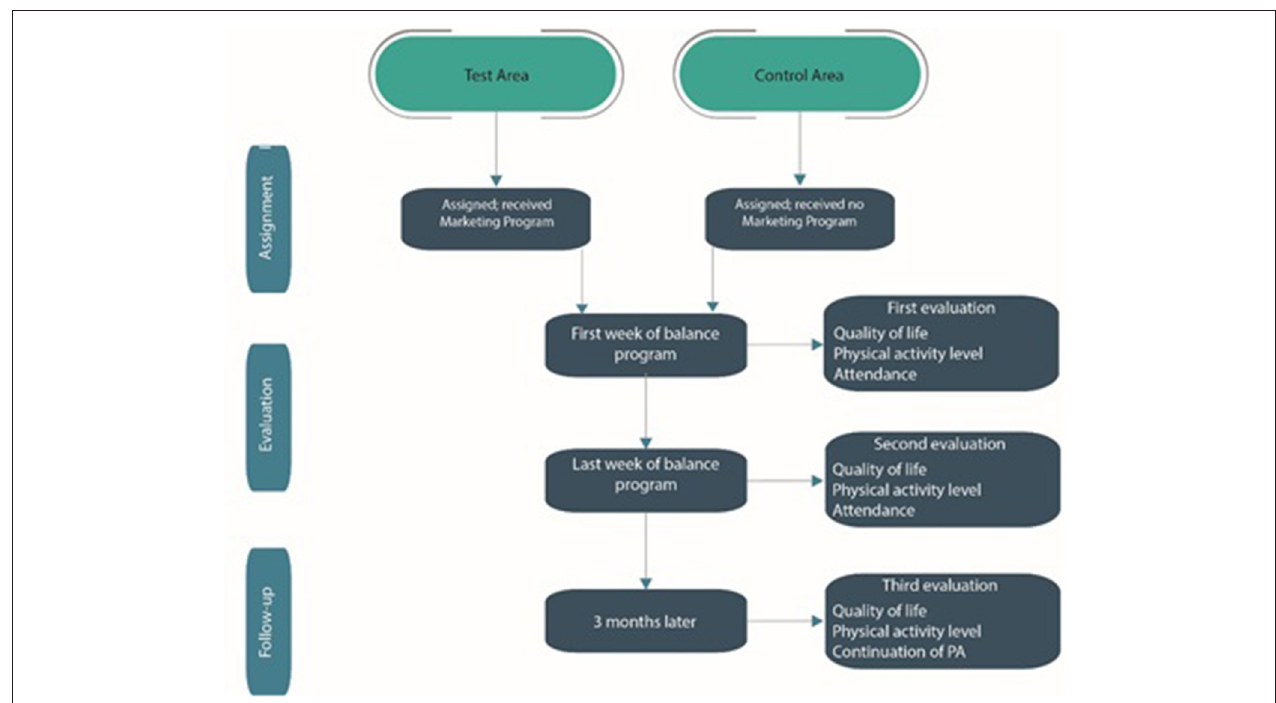
FIGURE 2 | Flow-chart of the